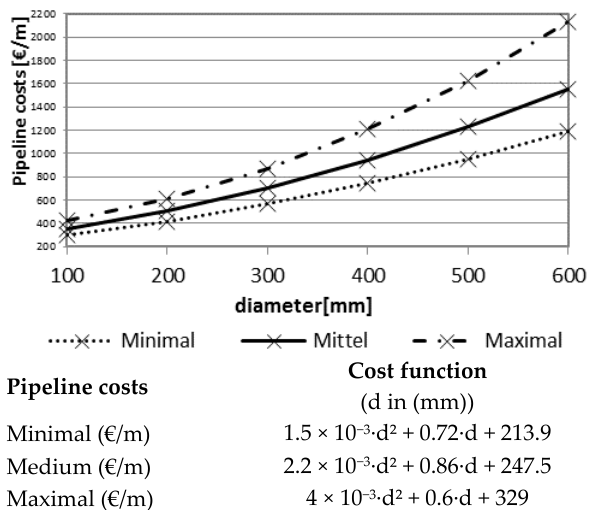
Figure 10. Cost function of pipeline costs, including material and compression depending on diameter [29]. diameter